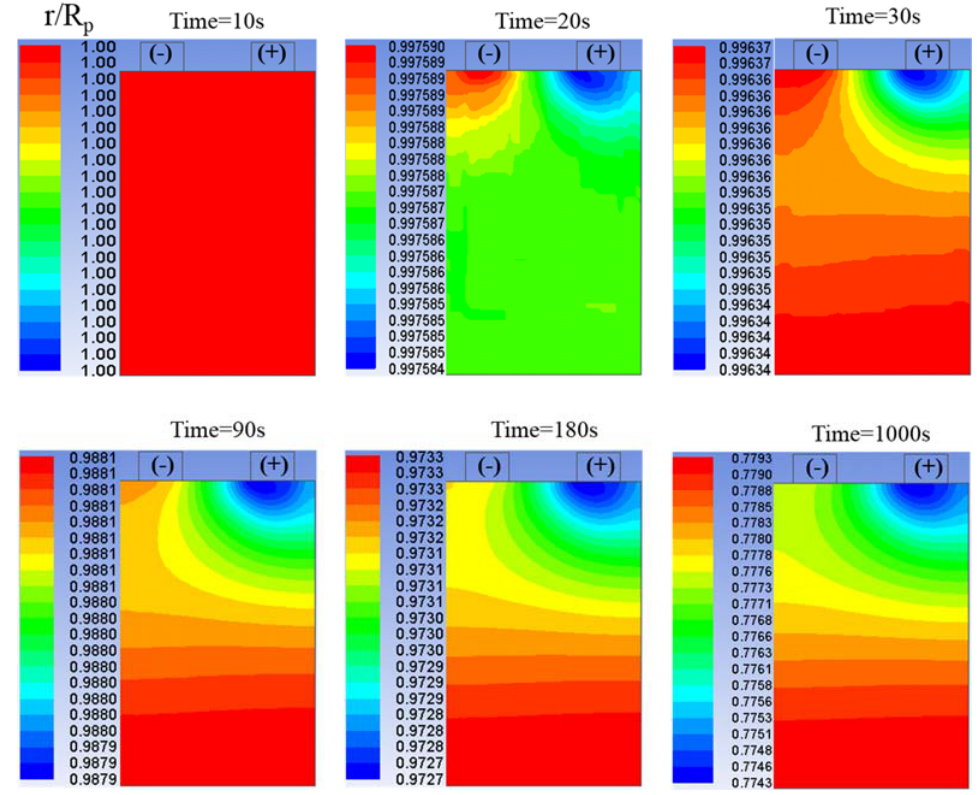
Figure 15. Contours of dimensionless phase interfacial location (r/R p ) between α and β phases in LFP particles over the middle of LFP electrode at 2 C rate for six different discharge elapsed times of 10 s, 20 s, 30 s, 90 s, 180 s and 1000 s.